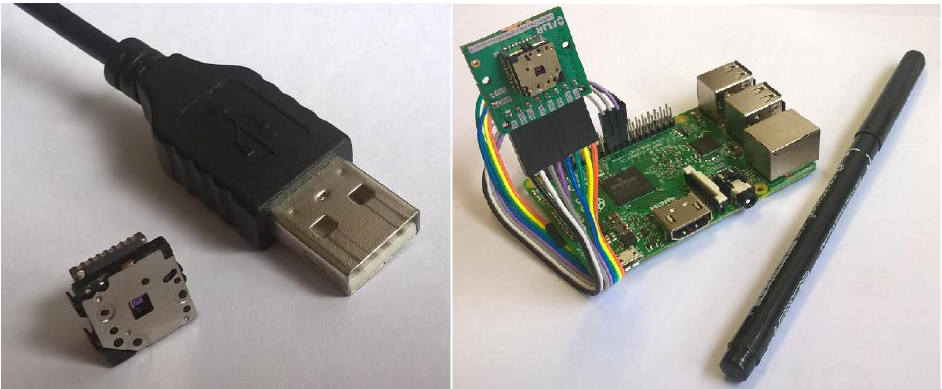
Figure 1. The FLIR Lepton camera (FLIR® Systems Italy, Limbiate, Italy) and its size comparison to a standard sized USB connector ( left ) and the sensor camera connected to the Raspberry Pi unit ( right ).